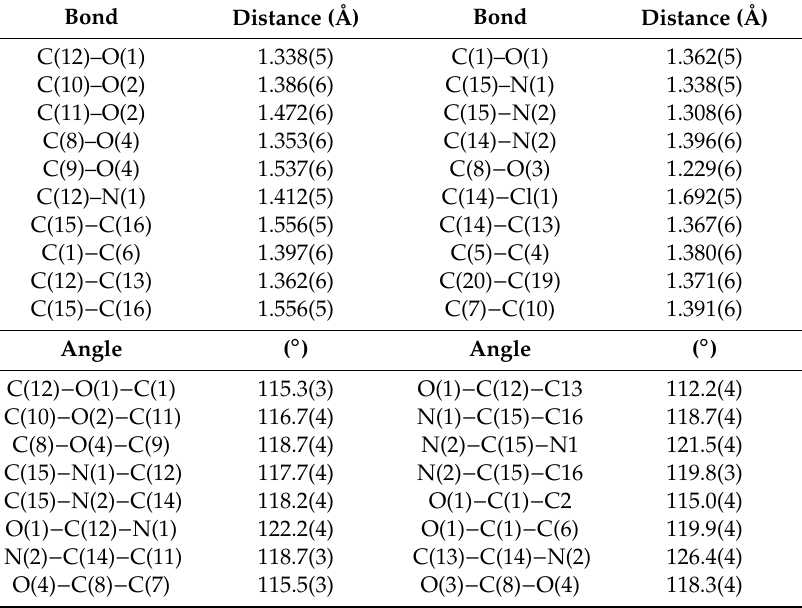
Table 2. Selected bond lengths (Å) and bond angles ( ◦ ) for compound 6 .